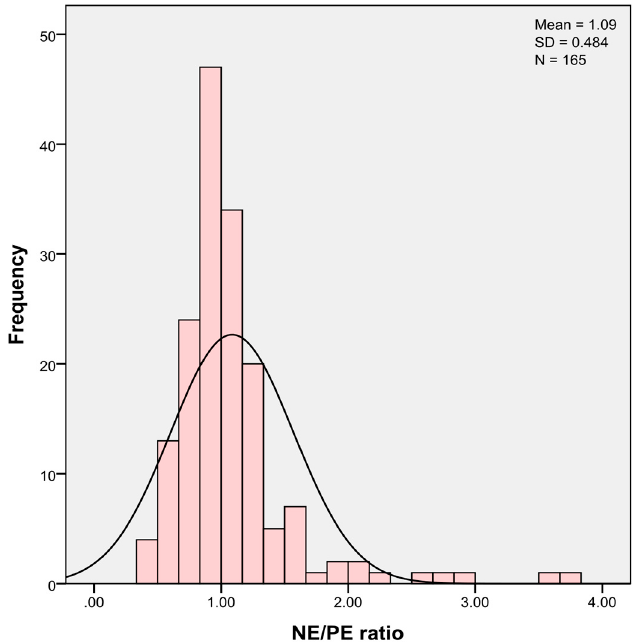
Figure 1. Distribution of NE/PE ratio in the sample. Abbreviations: NE/PE = negative emotional- ity/positive emotionality; SD = standard deviation.